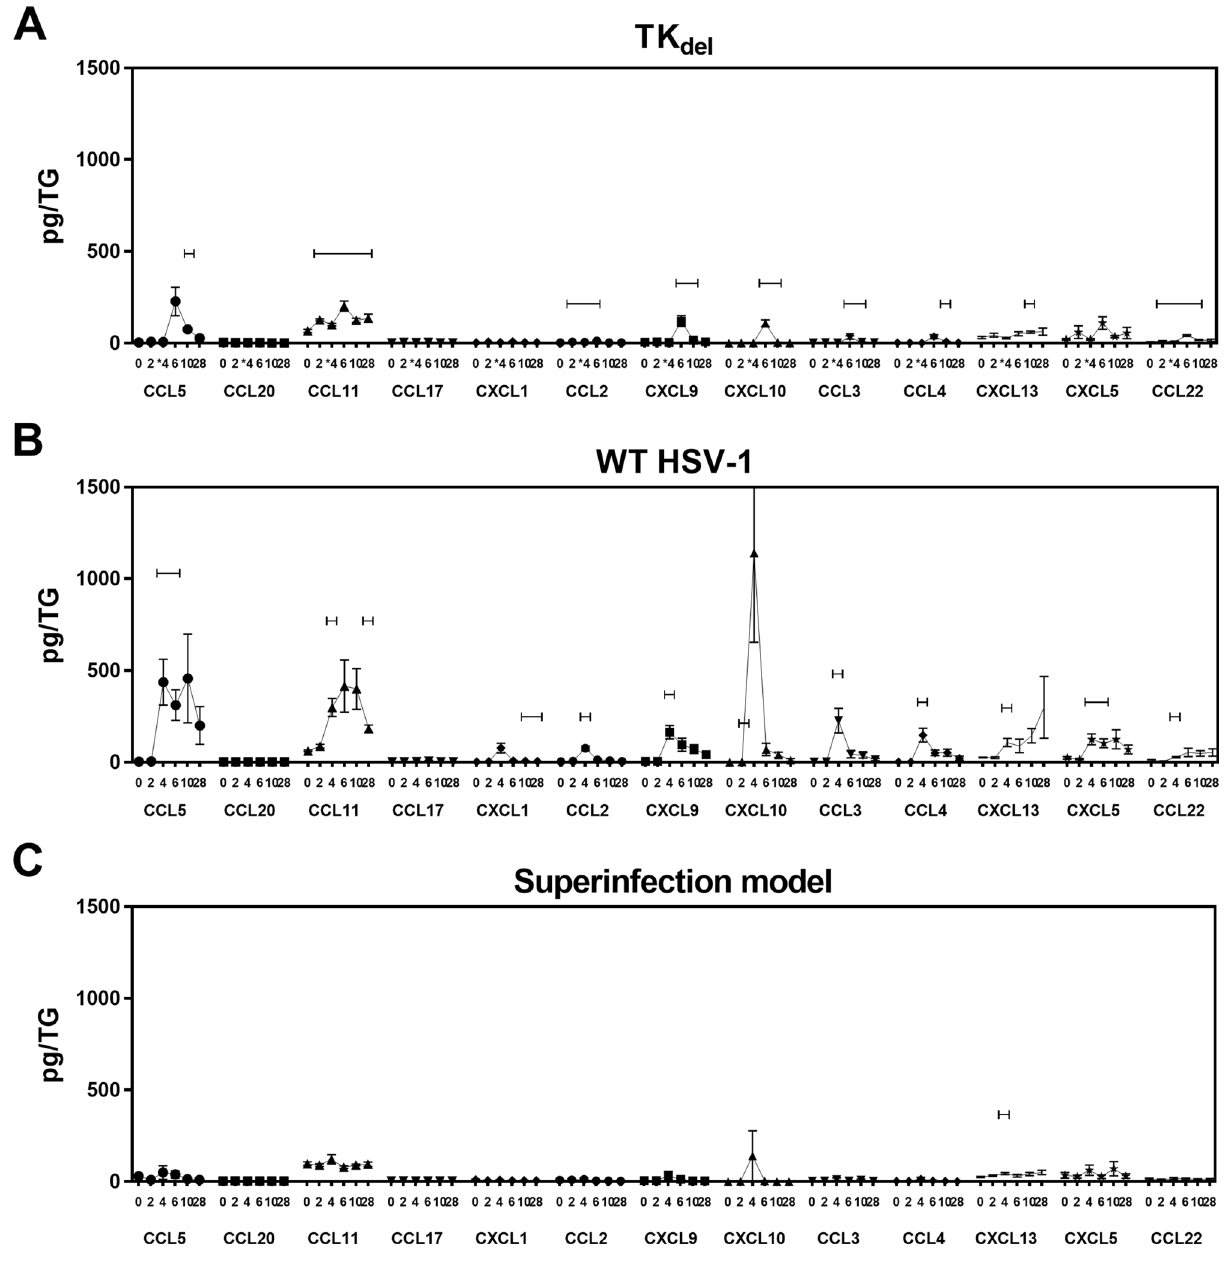
Figure 3. Inflammatory chemokines in the iTG. Naïve mice were infected in the lip with TK del ( A ), or WT HSV-1 ( B ) on day 0. Superinfection model mice were initially infected with TK del in the right lip on day -4, and then challenged with WT HSV-1 in the left lip on day 0 ( C ). Inflammatory chemokines in non-denatured iTG lysates were quantified using multi-analyte flow cytometry assay. Bars indicate significant difference from uninfected day 0 ( p < 0.03; T-test ). Each point represents n = 4 independent biological replicates. Figures were formulated using LEGENDplex software, Excel and Priming enhanced lymphocytic infiltration of the challenged lip.